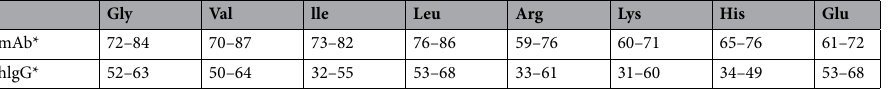
Table 1. Overall recovery yields of F(ab ′ ) 2 via Strategy II from either a mAb or polyclonal human IgG (hIgG). *Values represent at least 3 independent